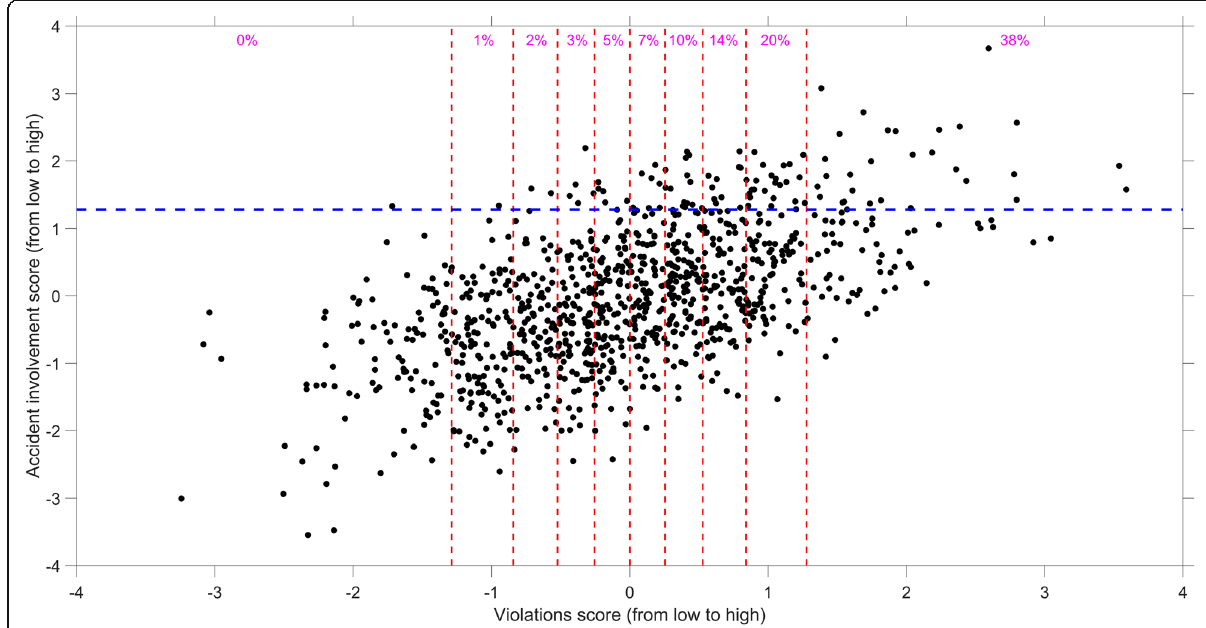
Fig. 3 Scatter plot of 1000 drivers with a correlation r = 0.6 between drivers ’ accident involvement scores and violations scores. The horizontal blue line is drawn at the 90th percentile of the accident involvement score; it is assumed that drivers with an accident involvement score higher than the 90th percentile will be involved in an accident (i.e., the overall accident rate is 10%). The vertical red lines are drawn at each 10th percentile of the violations score, and the percentage at the top shows the expected accident involvement rate of drivers within that